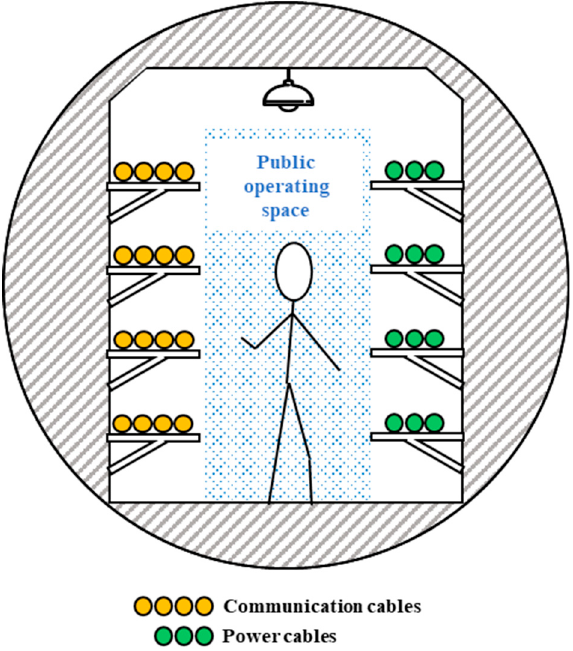
Figure 1. Cross-sectional view of the UUT laying power cables and communication cables.